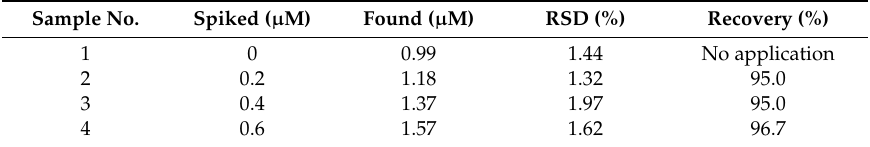
Table 3. Detection of luteolin in Duyiwei capsule using the standard addition method (n = 3). Sample